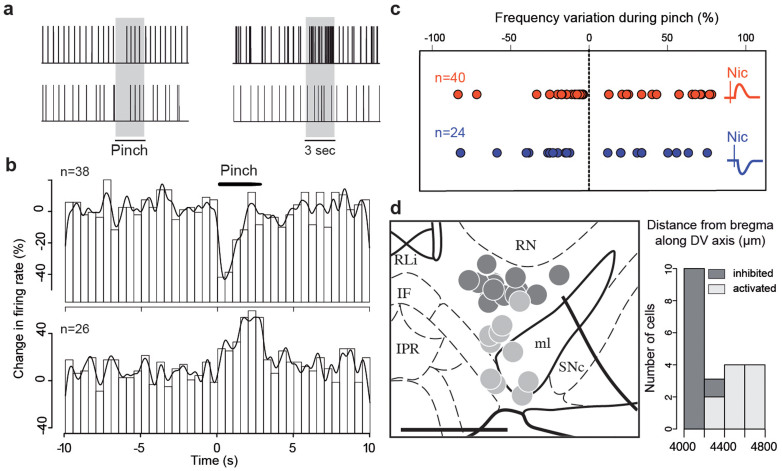
Inhibition and excitation of DA neurons in response to noxious stimuli.(a) Rasters representing the in vivo activity of two example neurons inhibited by a pinch (left) and two example neurons activated by a pinch (right). Grey area represents duration of pinch. (b) Population peristimulus time histogram (500 ms bins) averaging the activity of 38 pinch-inhibited neurons (top) and pinch-activated neurons (bottom, n = 26). (c) Frequency variation from baseline during pinch of neurons represented according to their response to nicotine. The responses of neurons excited by nicotine (red, n = 40) and inhibited by nicotine (blue, n = 24) do not correlate to their responses to a pinch. (d) Anatomical localizations within the VTA of confirmed DA neurons inhibited by a pinch (dark, n = 13) and activated by a pinch (light, n = 10), Activated neurons are located more ventrally (4515 ± 59 μm) than inhibited neurons (4230 ± 10 μm), p < 0.001, Wilcox test (scale bar: 0,5 mm).